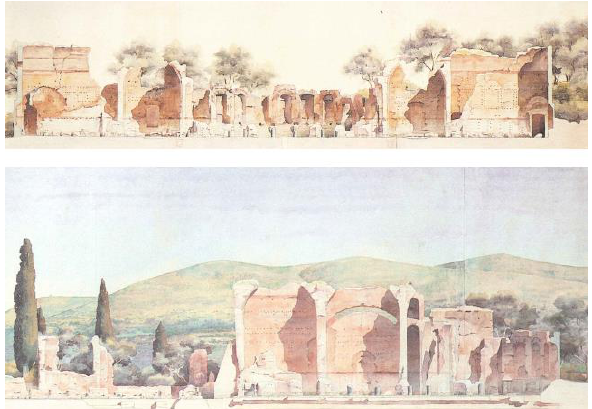
Figure 5. Two details of the sections passing through the southern area of the Piazza d’Oro at Hadrian’s Villa by Charles- Louis Girault (1885). These drawings are still an important documentation source for comparisons, analysis, study.